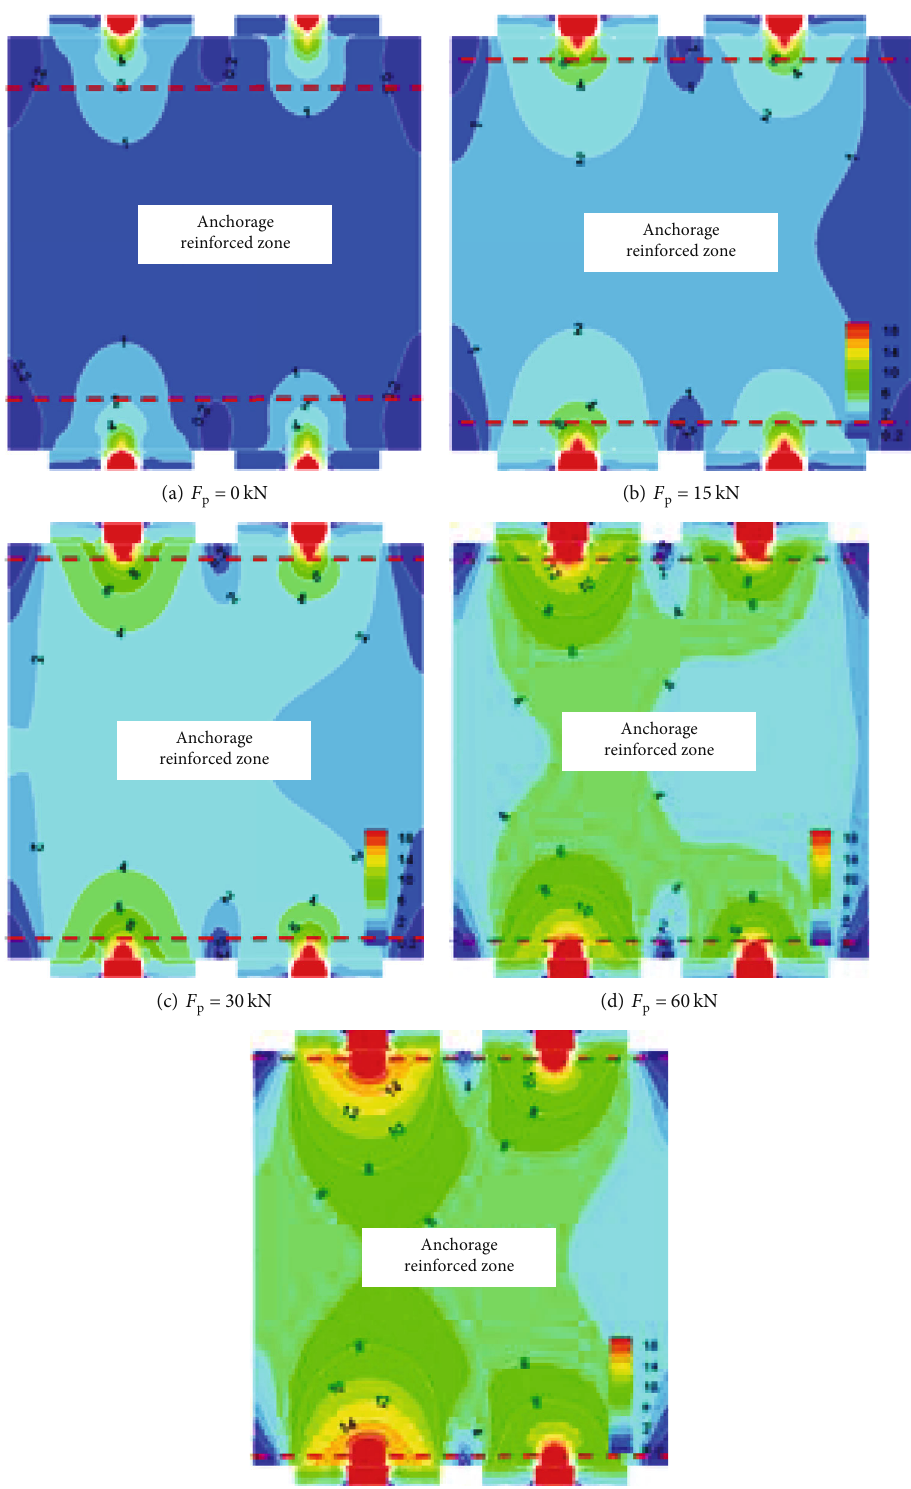
Figure 12: Anchorage stress distribution of rock mass specimen with di ff erent pretightening